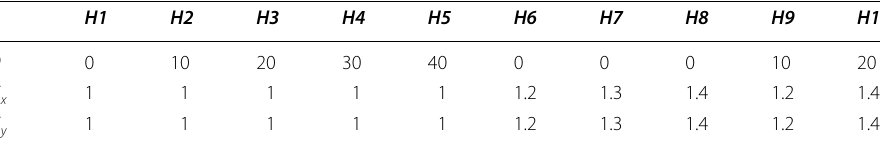
Table 2 Type of geometric attack in MICC‑F220 dataset